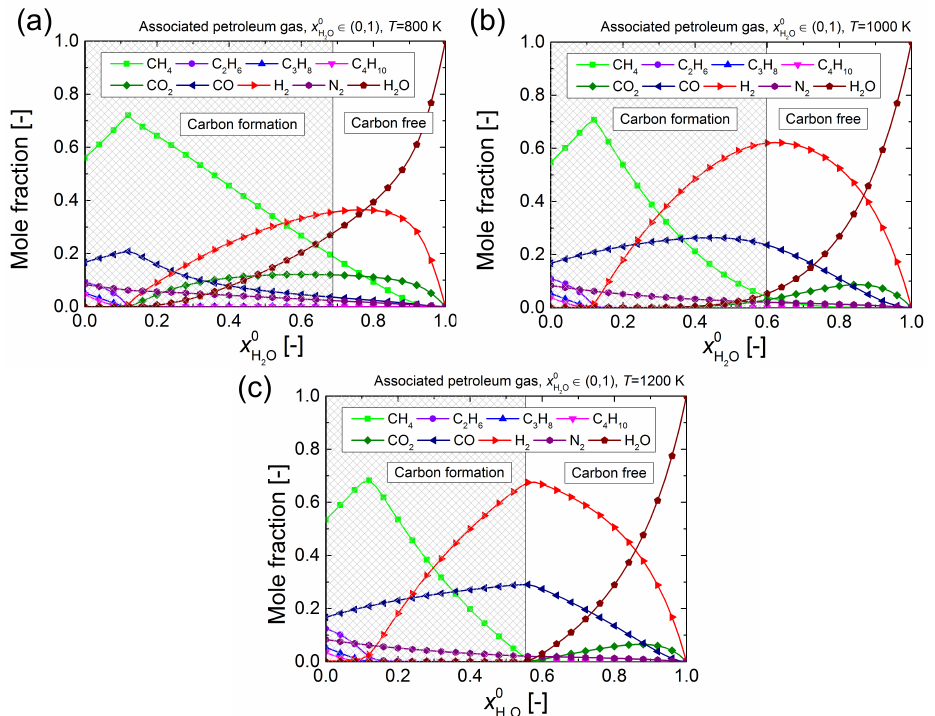
Figure 5. Equilibrium composition of reformed associated petroleum gas as a function of steam content ( a ) at 800 [K], ( b ) at 1000 [K] and ( c ) 1200